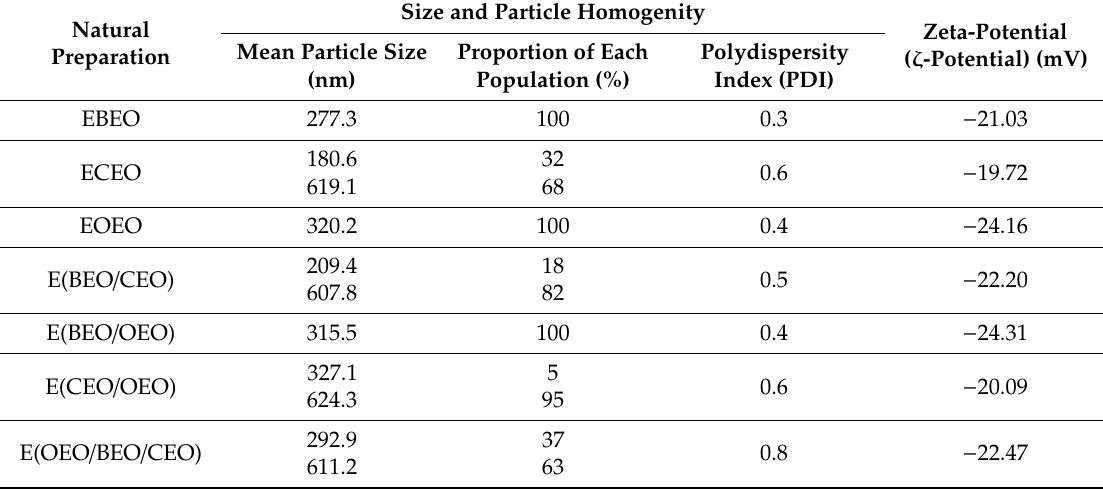
Table 2. Mean particle size (nm), polydispersity index (PDI), Zeta-potential ( ζ -Potential) (mV) of natural